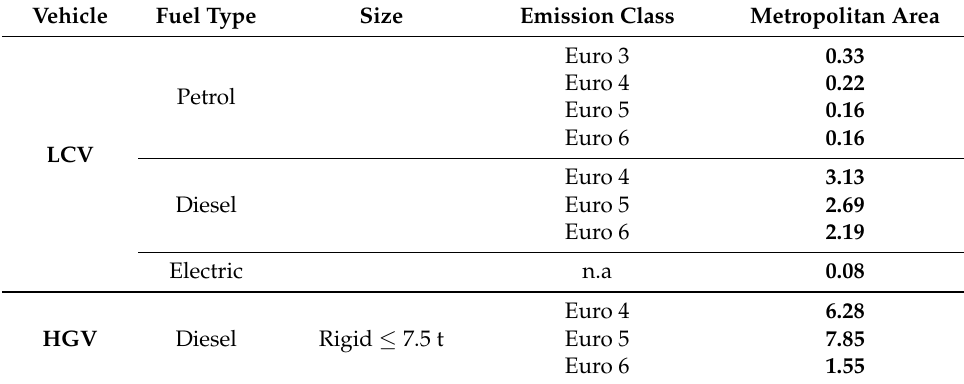
Table 9. Pollutant emission cost ( e -cent per